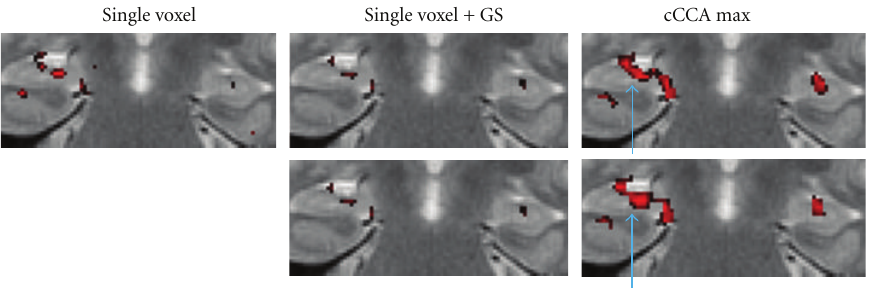
Figure 9: Magnified memory activation maps from Figure 7 for selected analysis methods (single voxel without Gaussian smoothing, single voxel with Gaussian smoothing (GS), and CCA with the maximum constraint (cCCA max)). The top row shows the original images at FWE < 0.05 without any correction for the smoothing artifact. The bottom row shows the original images corrected for the smoothing artifact. The blue arrows point to major di ff erences of the activation patterns. Note that hippocampal activation after correction for the smoothing artifact appears to have three separate foci in the right temporal lobe (radiological convention) as shown in the bottom image on the right (blue